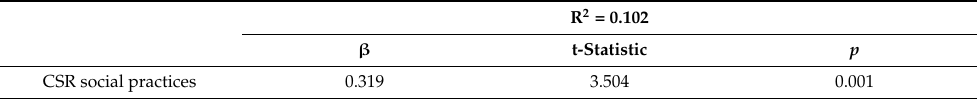
Table 6. Result of backward stepwise regression of the dependent variable-digitalization in relation to types of CSR.